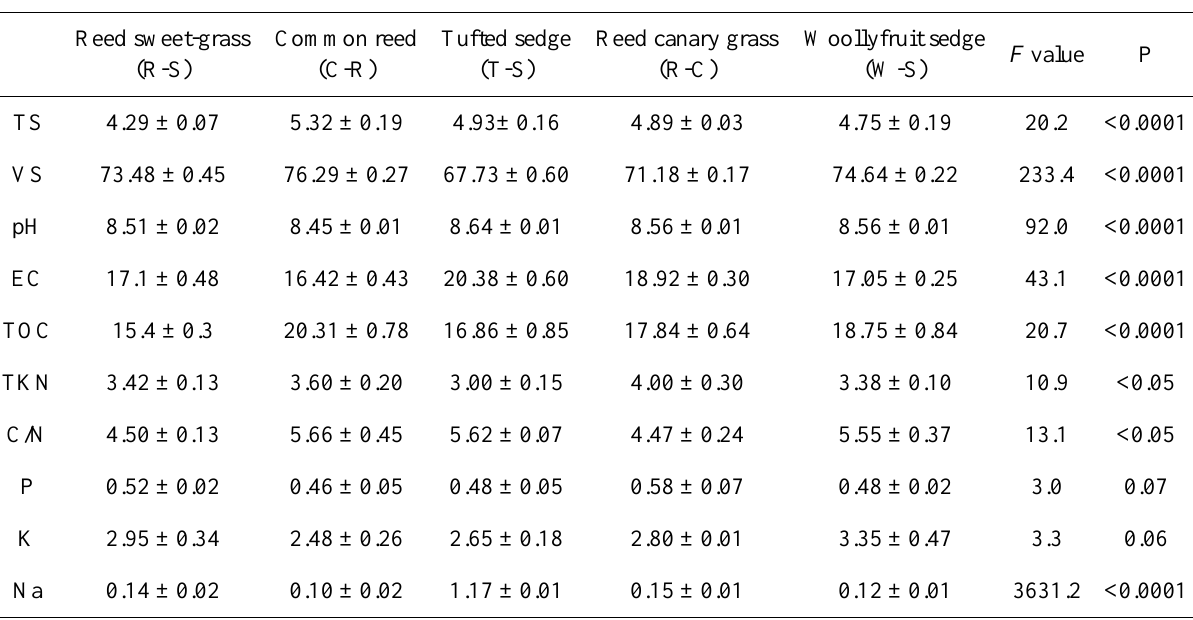
Table 2. Physical and chemical properties of the digestates and statistical significance between properties (mean value ± standard deviation ( n=3 ), data expressed on a fresh weight basis). TS = total solids (%); VS = volatile solids (% of TS); pH = reaction; EC = electrical conductivity (mS cm -1 ); TOC = total organic carbon (g kg -1 ); TKN = total Kjeldahl nitrogen content (g kg -1 ); P = total phosphorus content (g kg -1 ); K = total potassium content (g kg -1 ); Na = total sodium content (g kg -1